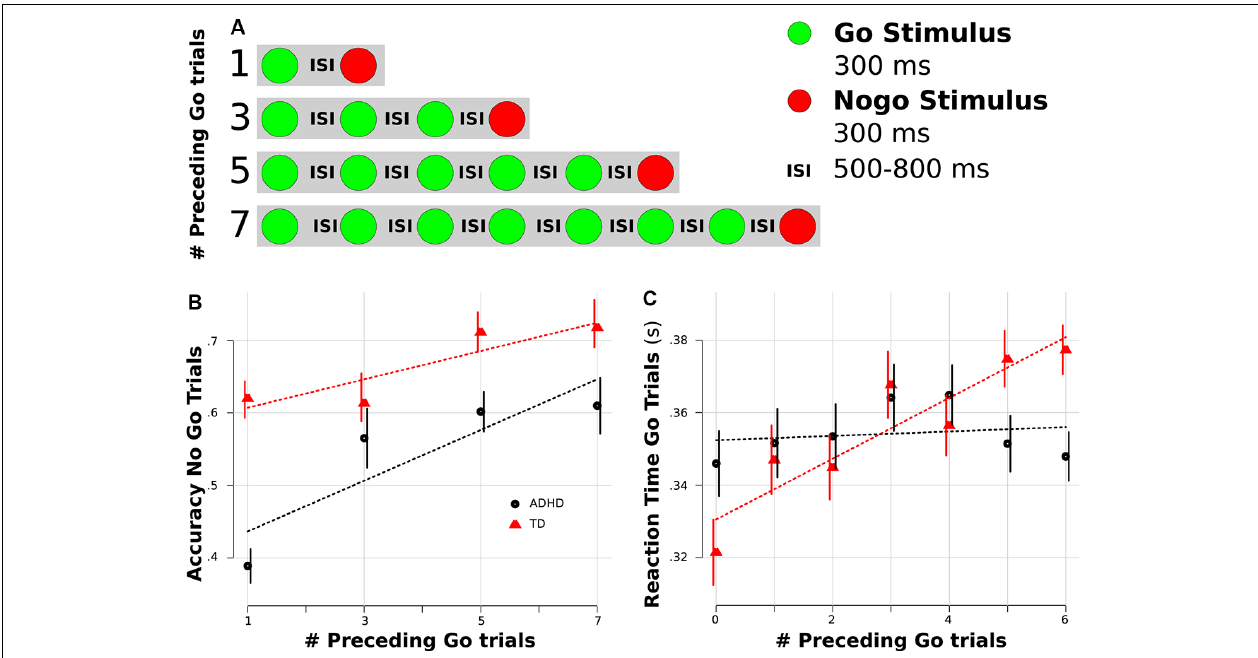
FIGURE 1 | Behavioral results. (A) Task scheme. (B) Accuracy rate for Nogo trials separated by the number of preceding Go trials. (C) Reaction time (RT) for Go trials separated by the number of preceding Go trials. (B,C) Red color represents typically developing (TD) children, and black indicates Attention Deficit Hyperactivity Disorder (ADHD) children. Dotted lines represent linear regression fitting. Error bars represent standard error of the